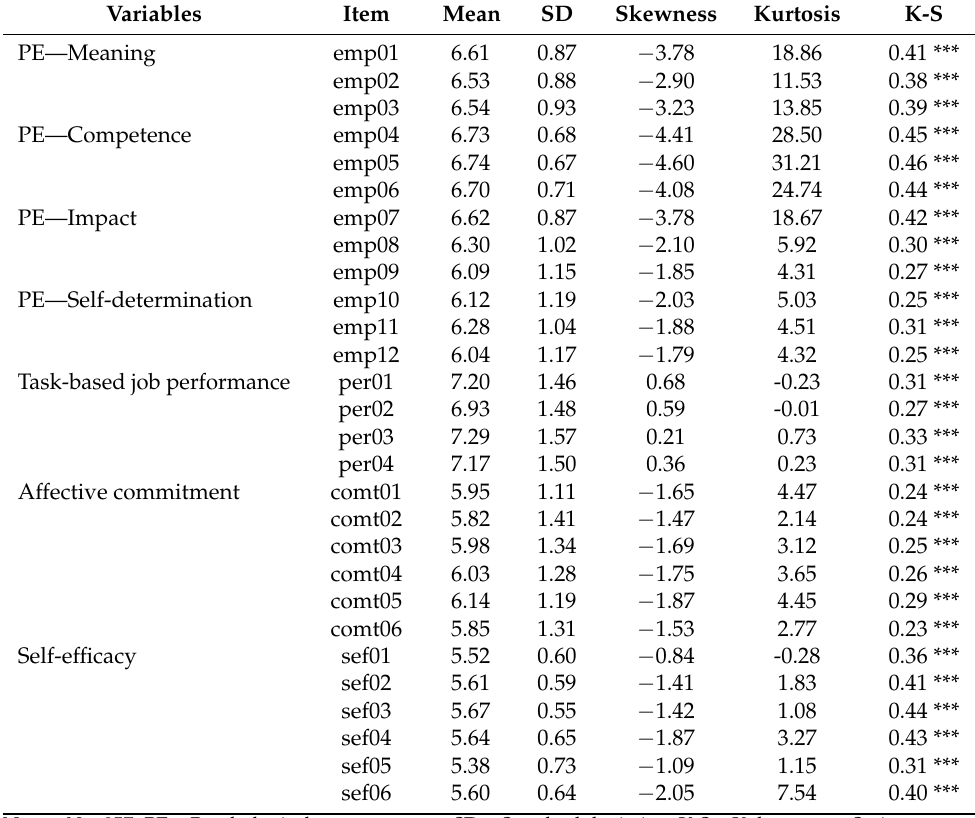
Table 1. Item descriptive statistics.